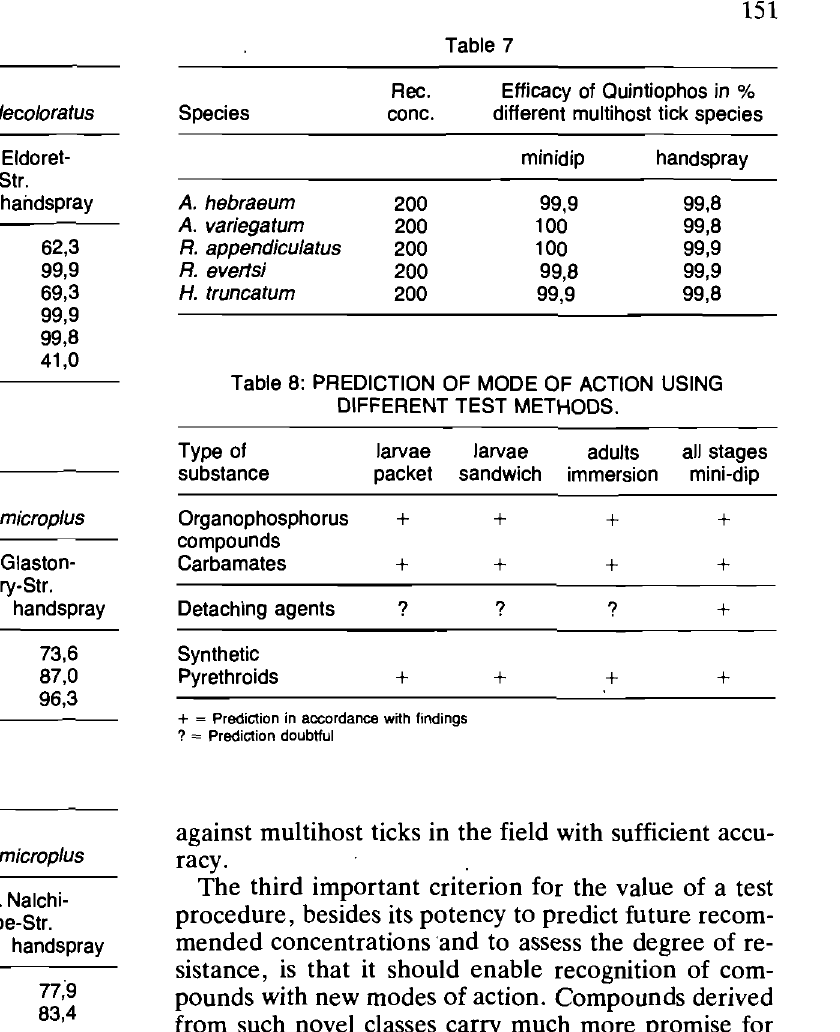
Efficacy in % Boophilus microplus